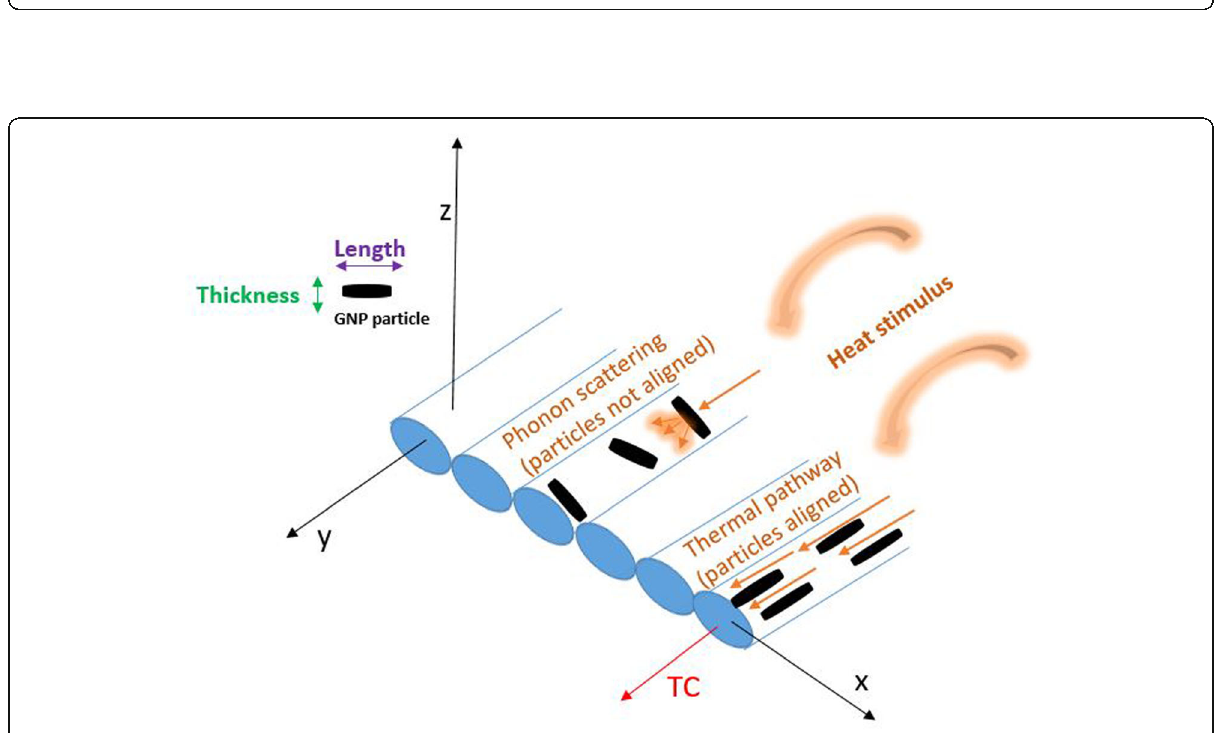
Fig. 3 Schematic illustration of thermal conduction within printed filaments of a composite of GNP and a polymer. When the GNPs are aligned along the conductive axis (y-axis) TC is